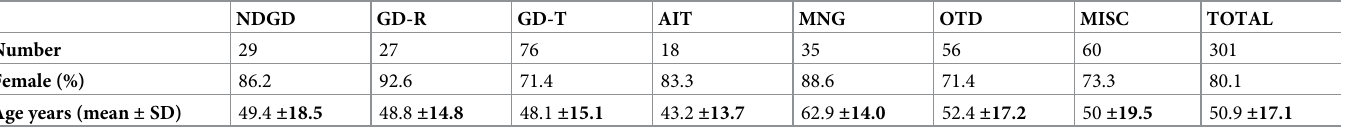
Table 1. Demographic and clinical data.